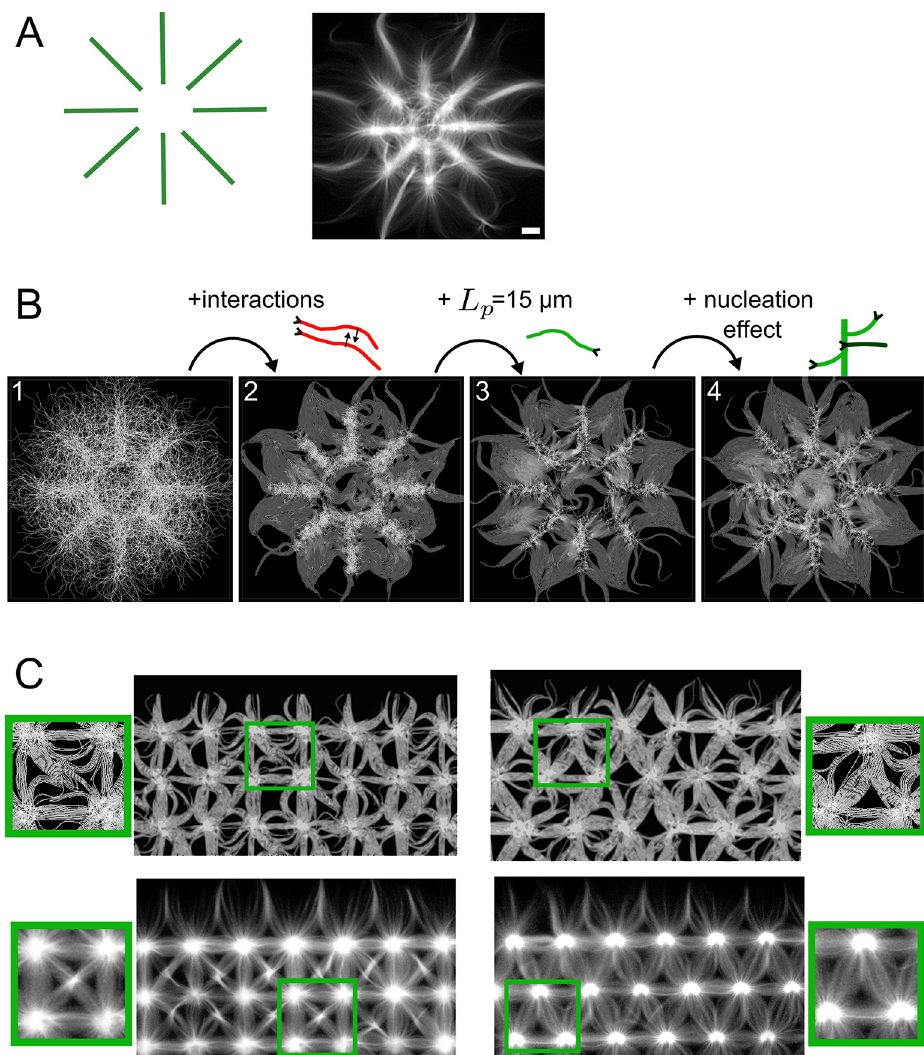
Fig 4. Contribution of studied parameters on actin organization. (A) Schematic of a micropattern, and the corresponding in vitro actin organization observed with TIRF microscopy. Scale bar is 10 μ m. (B) The contribution of the key elements of the model on the final organization of fibers in the simulation. (B1) Fibers that are nucleated locally but do not interact with each other fail to extend away from the micropattern, (B2) Adding the steric interaction with the parameters as calibrated in Fig 1 allows filaments to co-align and extend away from the nucleation zone. (B3) Setting the persistence length to 15 μ m (cf. Fig 2) makes them extend further. (B4) Adding the nucleation effect (cf. Fig 3, H2) finally leads to realistic overall densities (final time is 250 s). (C) Predictions of the actin filament organization for novel nucleation patterns. Simulations (Top) were done on a set of 8 points, distant by 6 μ m, and positioned on a square (left) or triangular (right) lattice. The 8-point units were repeated 9 times using periodic boundaries. (Bottom) Experimental verification of actin organization for the geometries